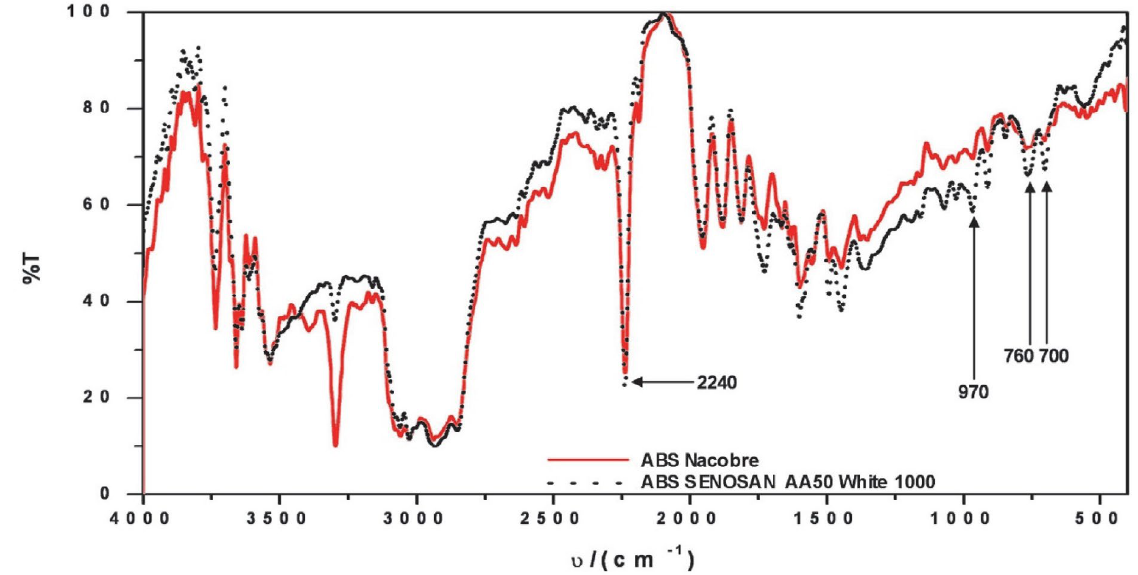
Figure 2. FT-IR spectra of ABS from Nacobre and SENOSAN AA50White